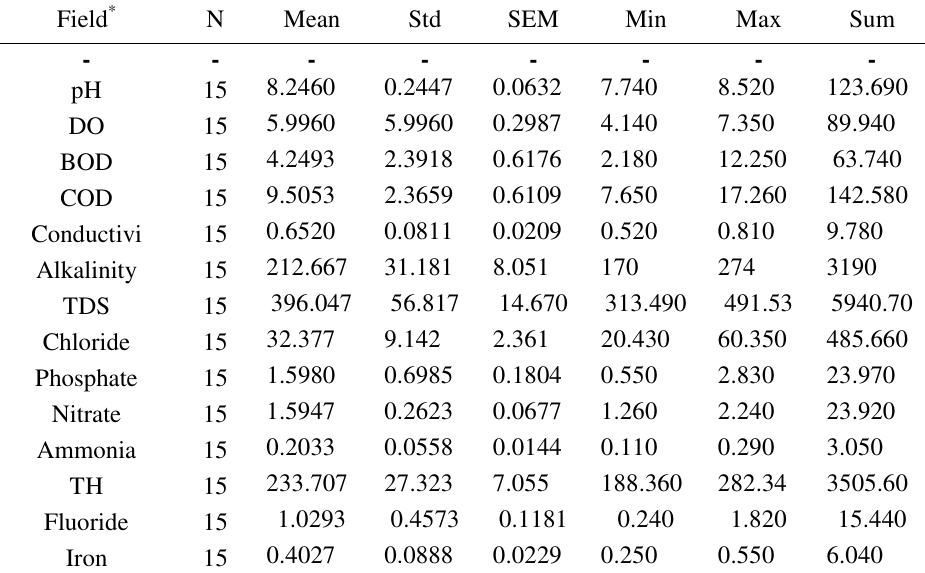
Table 8. Descriptive statistics (At pre-monsoon)